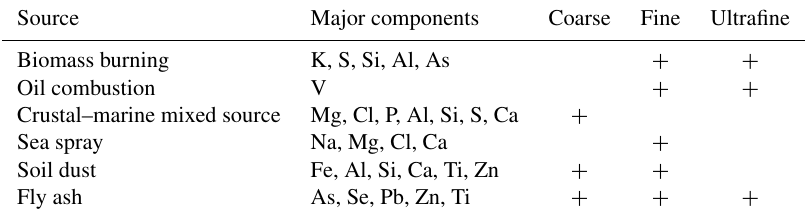
Table 2. Sources identified in each size range with PMF: coarse (1.15–10µm), fine (0.34–1.15µm), and ultrafine (0.10–0.34µm). Source Major components Coarse Fine Ultrafine Biomass burning K, S, Si, Al, As + + Oil combustion V + + Crustal–marine mixed source Mg, Cl, P, Al, Si, S, Ca + Sea spray Na, Mg, Cl, Ca + Soil dust Fe, Al, Si, Ca, Ti, Zn + + Fly ash As, Se, Pb, Zn, Ti + +